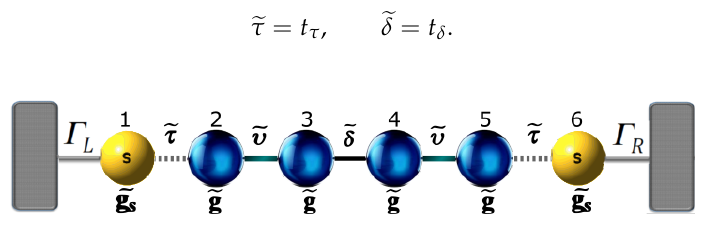
Figure A4. Molecular system with two renormalized thiophene